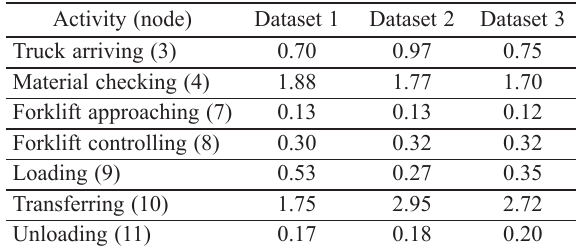
Table 2. Duration of activities in the unloading process